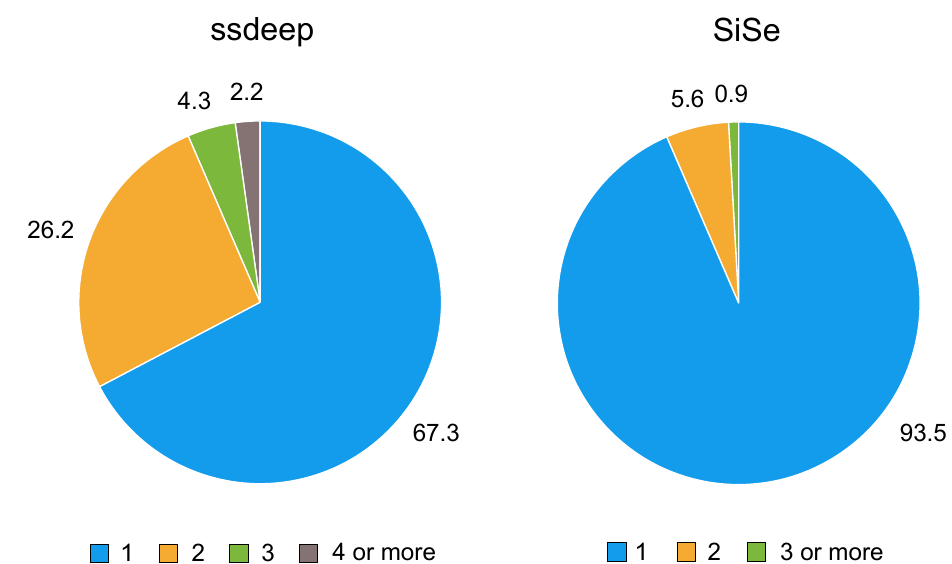
Figure 1. Percentage of files that need a different number of executions of the main